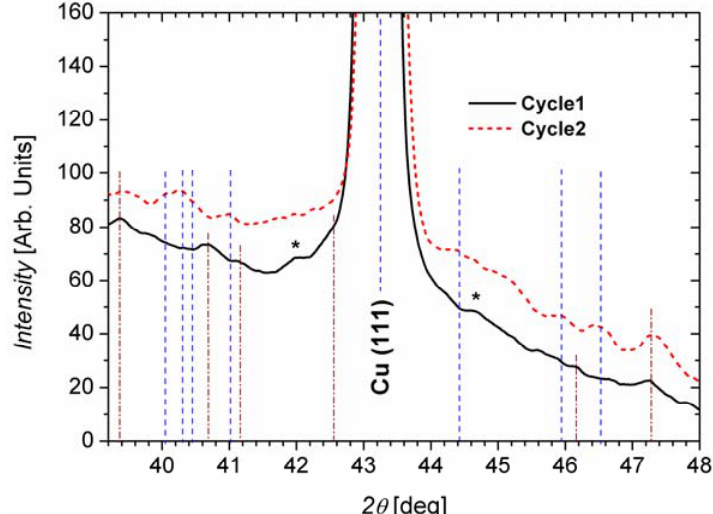
Figure 5. X-ray diffractograms of lithiated Si wire anodes after one and two charging cycles. The vertical lines are a guide for the eye to identify the different peaks. The peaks marked with an asterisk could not be assigned to a single Si-Li phase; in those ranges many low intensity reflections of different Li-Si phases are